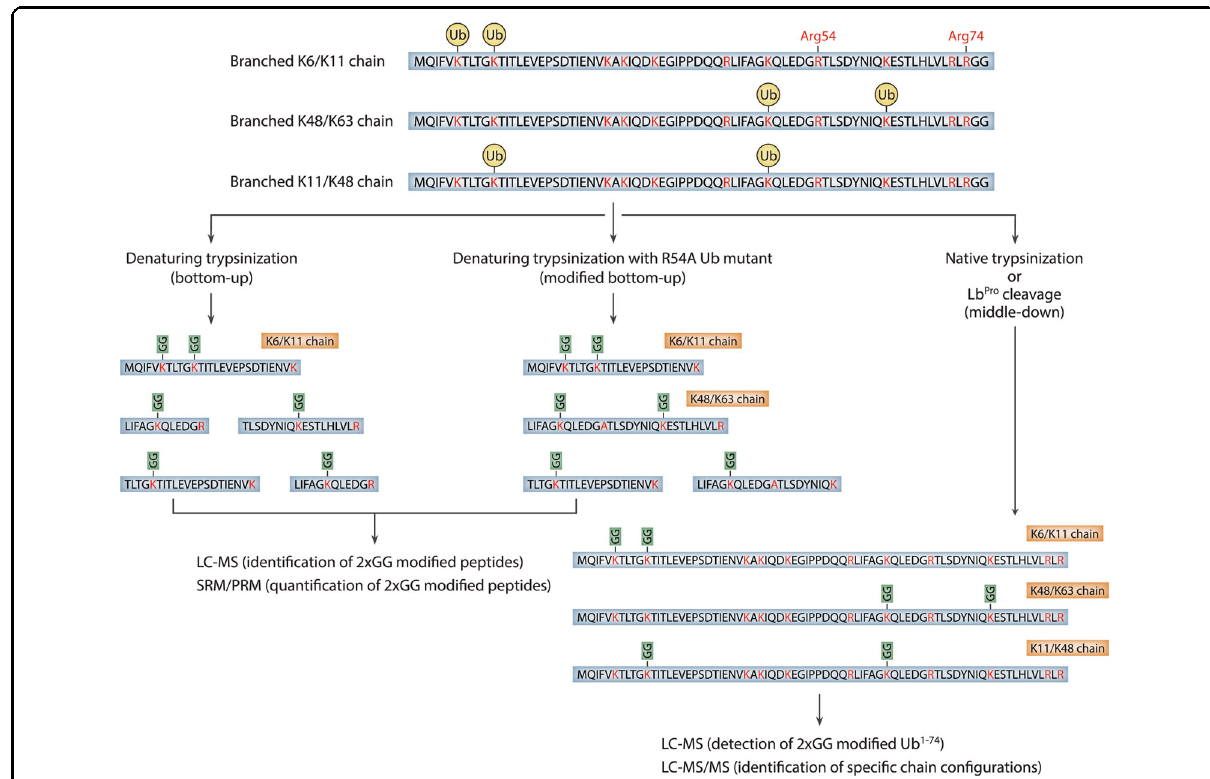
Fig. 4 Mass spectrometry-based work fl ows to detect branched ubiquitin chains. Three different approaches to detect branched chains are illustrated. In the classical bottom-up approach, branched chains involving neighboring lysines can be detected, but all other types of branched chains are invisible due to the cleavage of branched peptides at intervening lysines or arginines (left). Mutation of the single arginine located between K48 and K63 of ubiquitin (Arg54) allows the detection of branched K48/K63 chains using classical bottom-up methods (middle). In principle, other types of branched chains can be detected in this manner. In the middle-down approach, ubiquitin chains are digested with trypsin under native conditions or cleaved after Arg74 with a site-speci fi c protease (right). This approach leaves all possible combinations of branch points intact. Speci fi c chain con fi gurations can then be identi fi ed by tandem mass spectrometry. LC – MS liquid chromatography-mass spectrometry, SRM